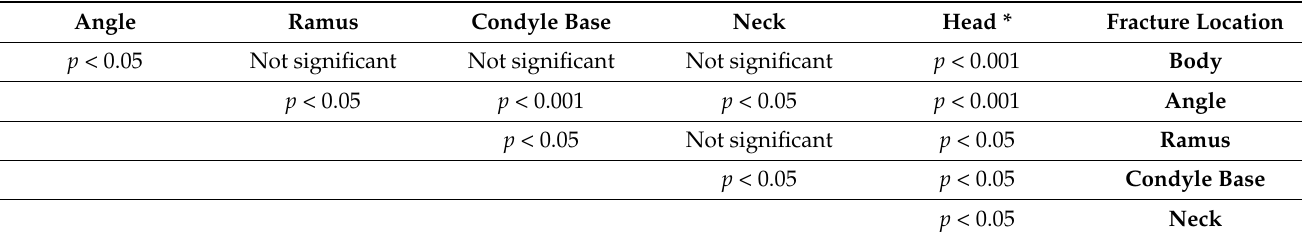
Table 3. Analysis of multiple fractures. Interrelationship of fracture sites in mandible.